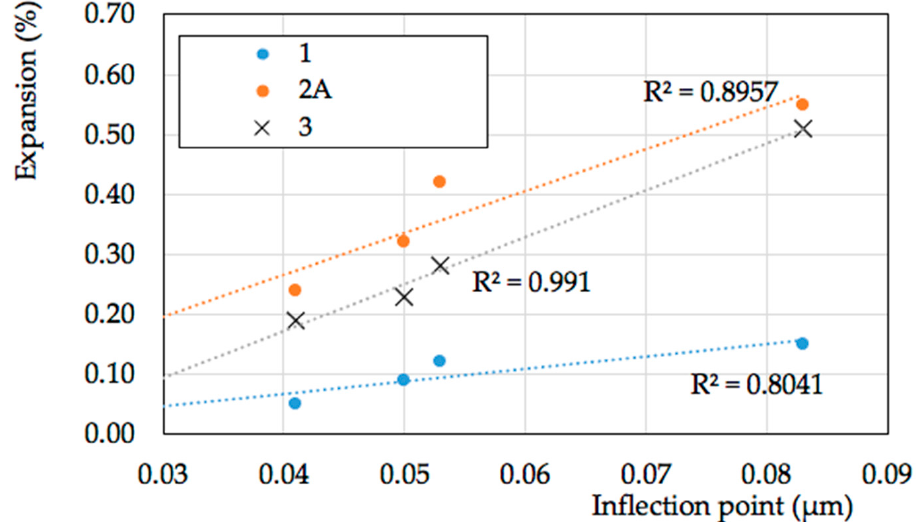
Figure 14. Expansion vs. dimension of the most frequent pore for 1, 2A, and 3 samples at the longer investigation times, i.e., 28 days for 1 and 2A and 60 days for 3 (R 2 values for linear interpolation reported).